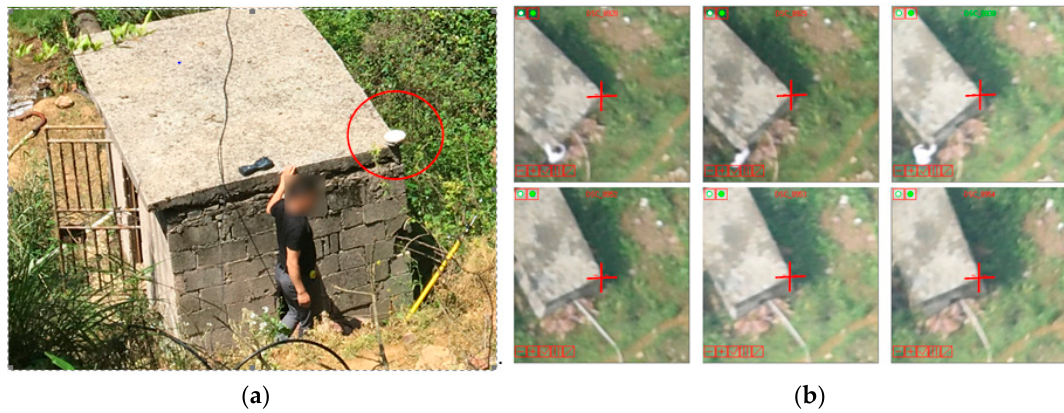
Figure 14. The location and image measurement of GCP No. 9012. ( a ) The location of No. 9012; ( b ) The image measurement of No. 9012; the red crosses represent the location of the GCP in the images.